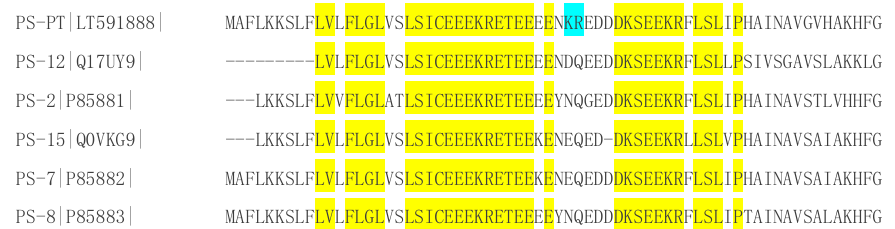
Table 3. Catabolites generated by incubation of PS-PT2 and its D -type analogues with trypsin or serum.